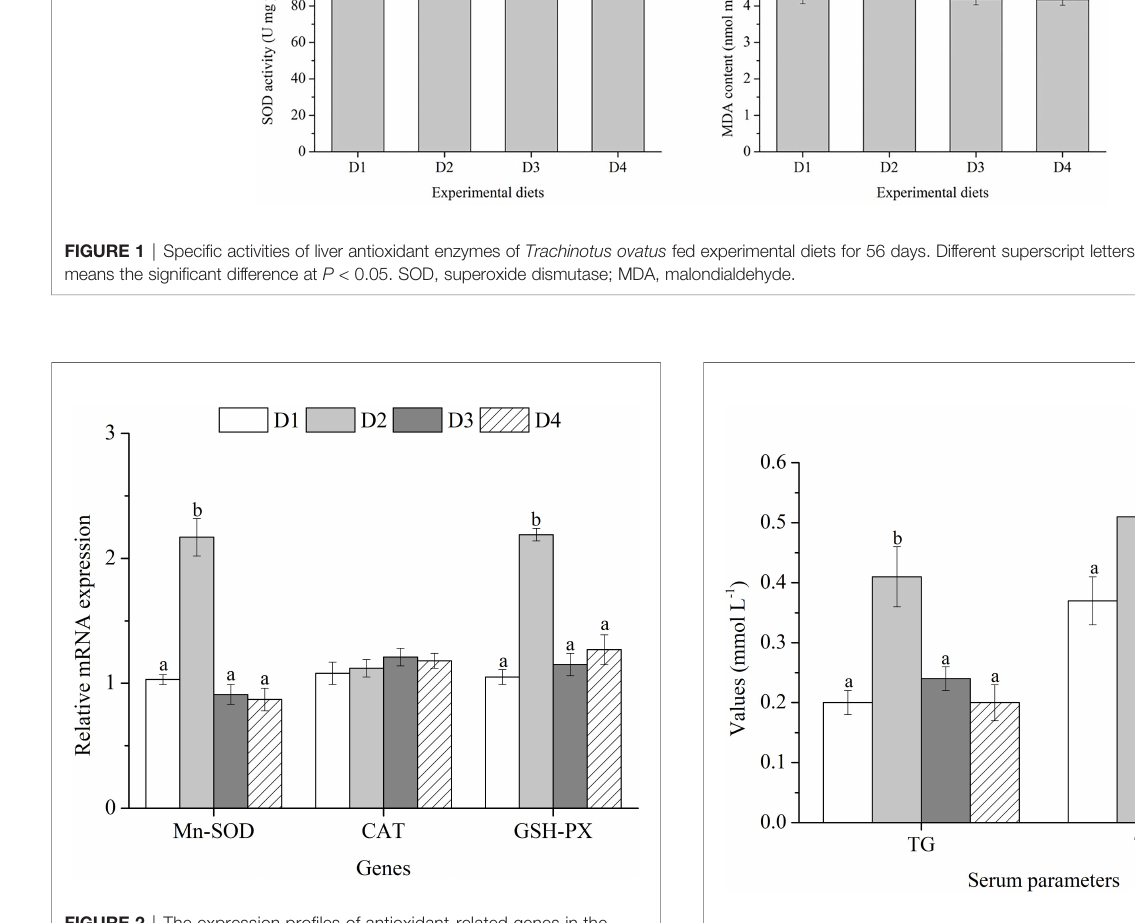
FIGURE 3 | Serum parameters of Trachinotus ovatus fed experimental diets for 56 days. Different superscript letters in the same row means the signi fi cant difference at P < 0.05. TG, triglyceride (mmol L -1 ); T-CHO, total cholesterol (mmol L -1